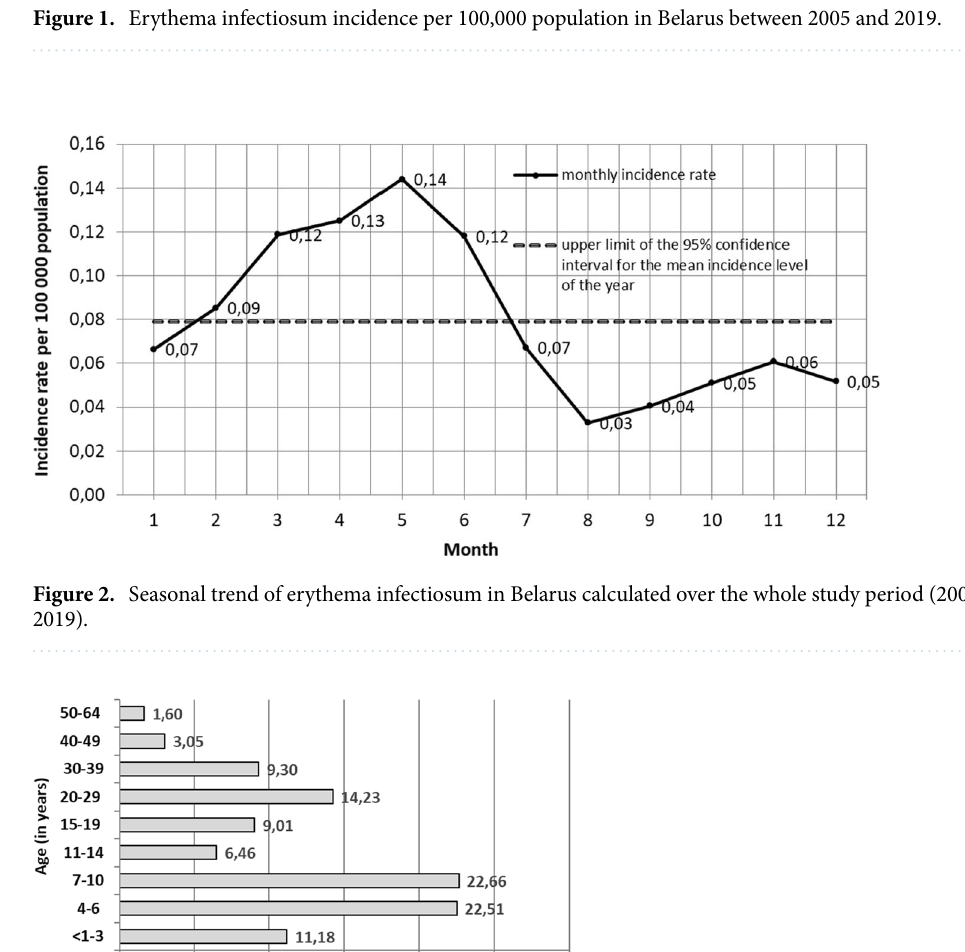
Figure 1. Erythema infectiosum incidence per 100,000 population in Belarus between 2005 and 2019.